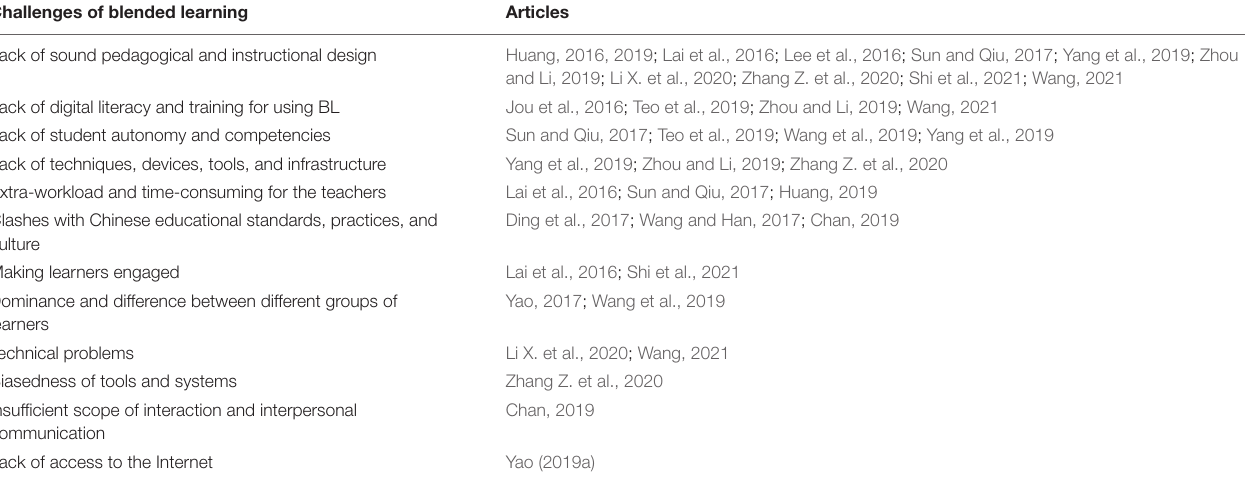
TABLE 6 | The challenges and drawbacks of blended learning in Chinese higher